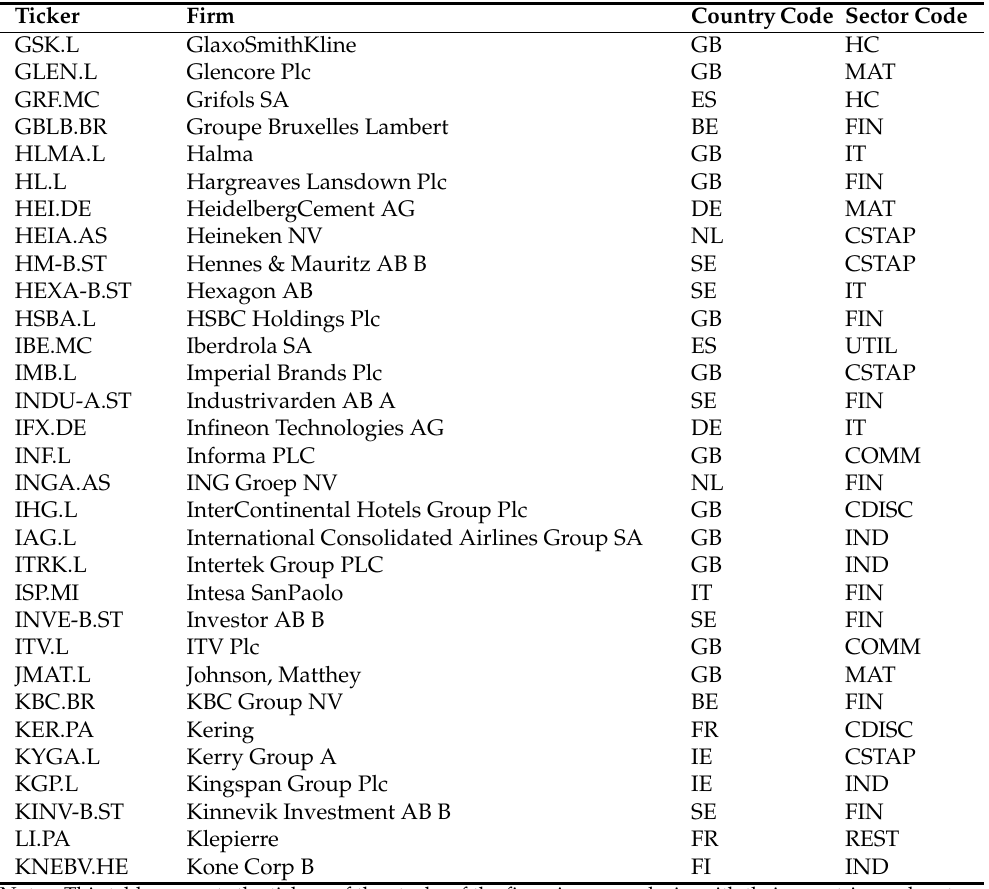
Table A6. Cont. Ticker